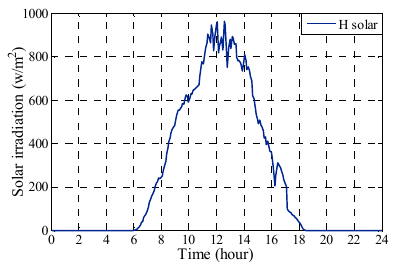
Figure 18. Measured outdoor temperature.